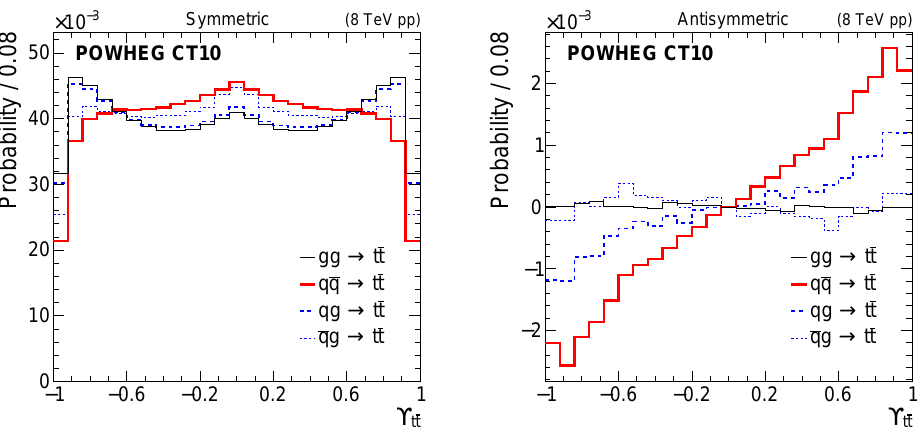
Figure 18. Symmetric and antisymmetric components of the binned probability distribution in the observable Y t ¯ t [51] constructed using the POWHEG generator